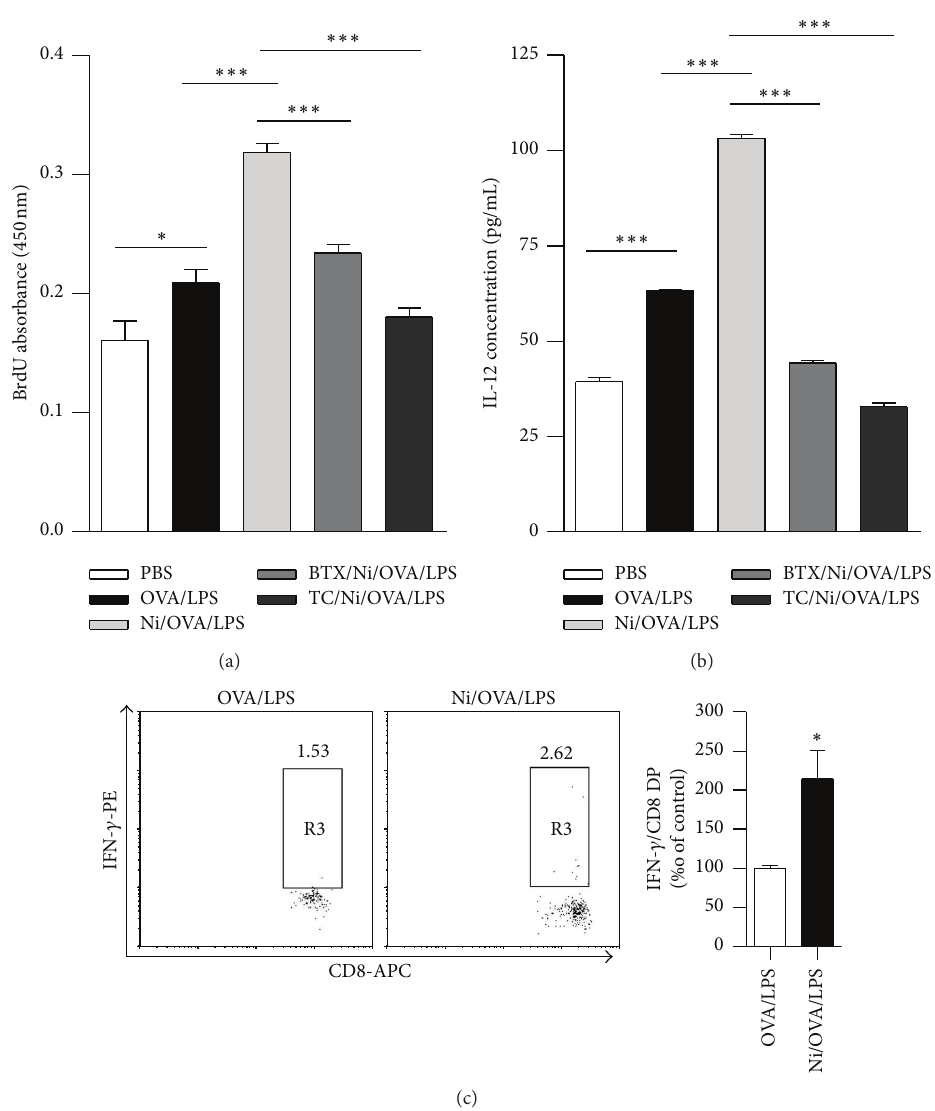
Figure 2: Ex vivo nicotine stimulation augments semimature DCs-mediated PBMC proliferation, promotes the release of IL-12, and increases the percentage of IFN-gamma/CD8 cells in the supernatant of cocultured DCs-PBMC. DCs derived from human PBMC with 100ng/mL recombinant human GM-CSF and IL-4 were conferred with 𝛼 -bungarotoxin (2 𝜇 g/mL) or tubocurarine chloride (4 × 10 −5 mol/L) 2h prior to nicotine (10 −7 mol/L) 12 ∼ 15h stimulation. Then, the DCs were pulsed with endotoxin-free EndoGrade-ovalbumin (50 𝜇 g/mL) for 3 h, followed by 1h LPS (1ng/mL) stimulation. After that, the DCs were coincubated with PBMC of the same donor at a ratio of 1:1 for 5 d and the effect of nicotine on DCs-mediated PBMC proliferation, the IL-12 release in the supernatant, and IFN-gamma/CD8 cell percentage of cocultured DCs-PBMC were determined by BrdU cell proliferation assay (a), ELISA (b), and flow cytometry (c), respectively. Data were given as mean ± SEM, 𝑛 = 2 , one-way ANOVA with post-Newman-Keuls test. ∗ 𝑃 < 0.05 , and ∗∗∗ 𝑃 < 0.001 . One representative from 3 independent experiments is shown. Ni: nicotine; BTX: 𝛼 -bungarotoxin; and TC: tubocurarine